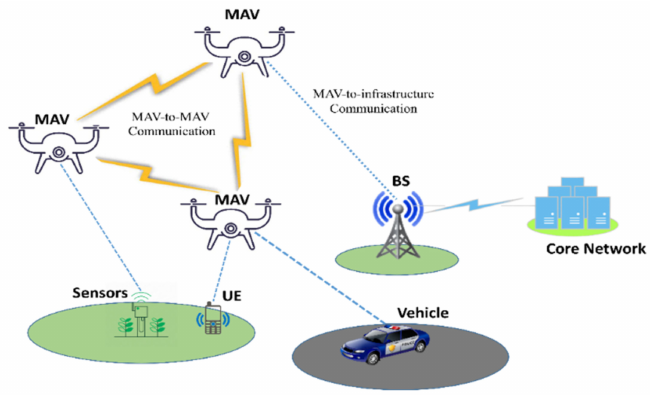
Figure 1. General architecture of MAVs